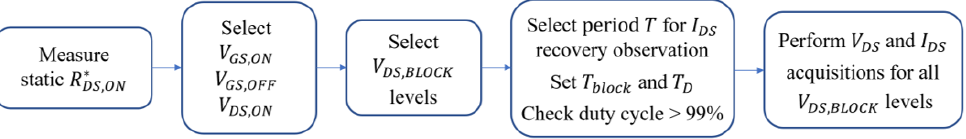
Figure 2. Setting and steps of the proposed measurement procedure under periodic